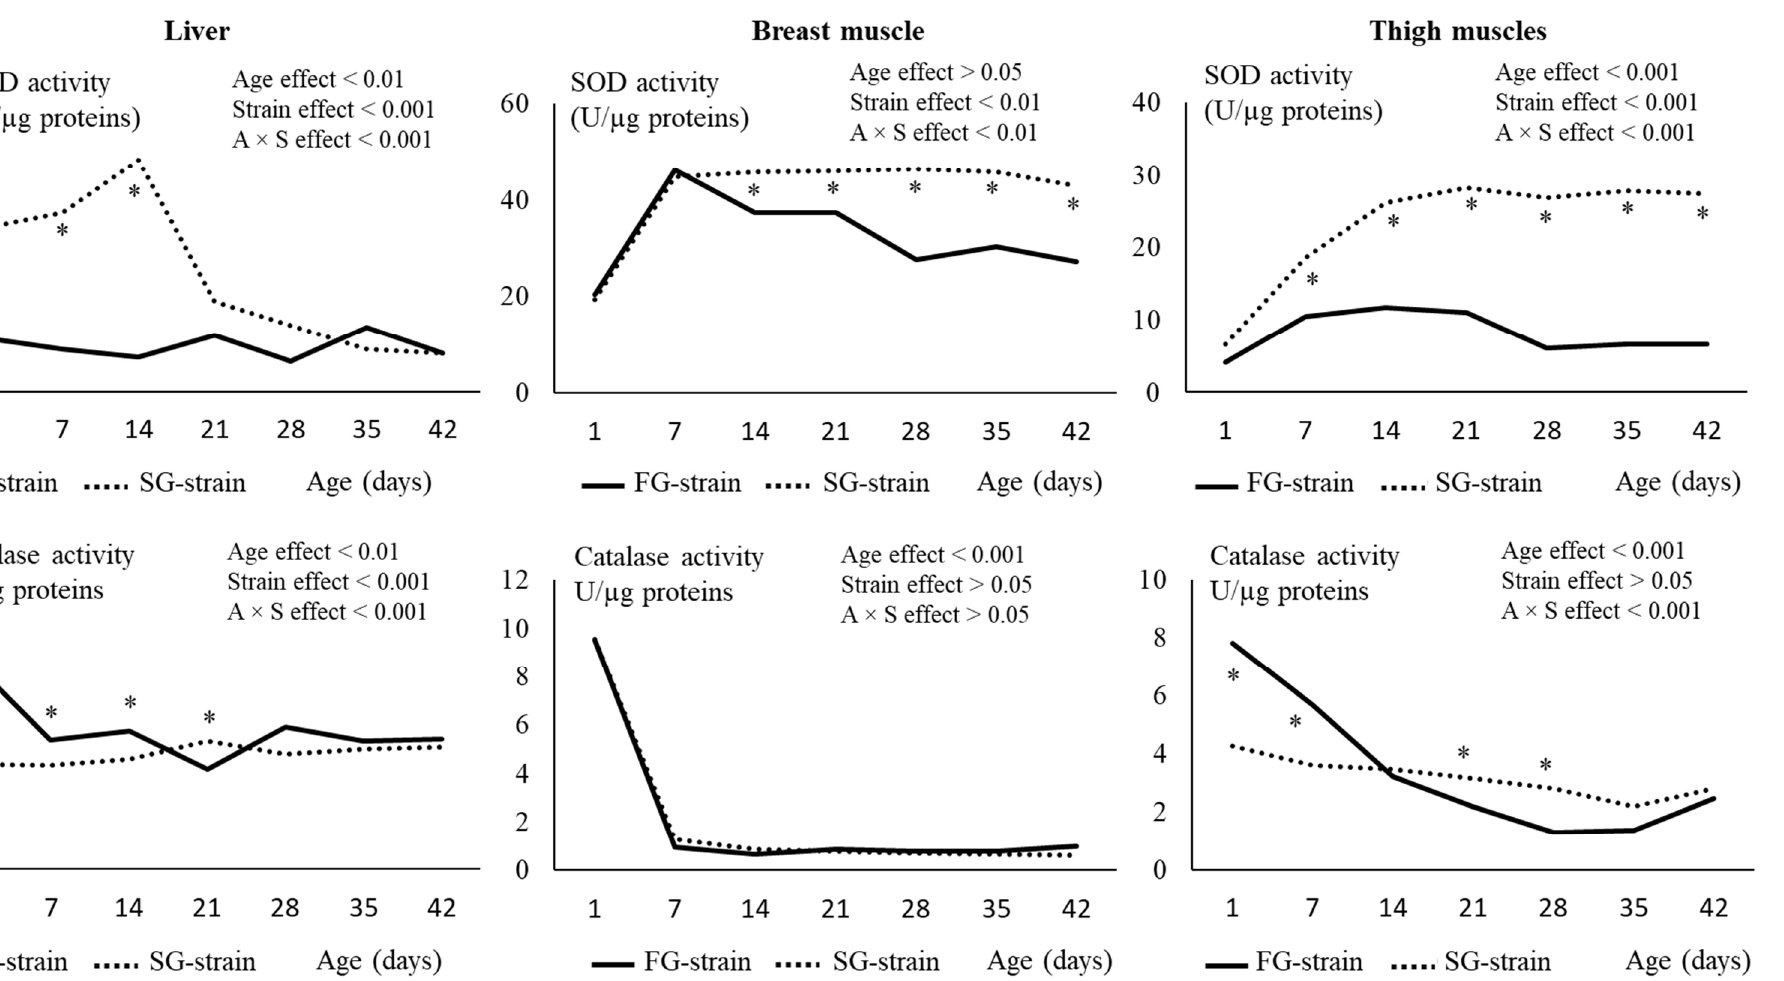
Figure 6. Effects of age (A) and strain (S) and their interaction on superoxide dismutase (SOD) and catalase in the liver, breast, and thigh muscles. Data are presented as the means; n = 10 per strain and per age. *: Significant difference ( p < 0.05) between strains for a given age; FG = fast-growing, SG = slow-growing.